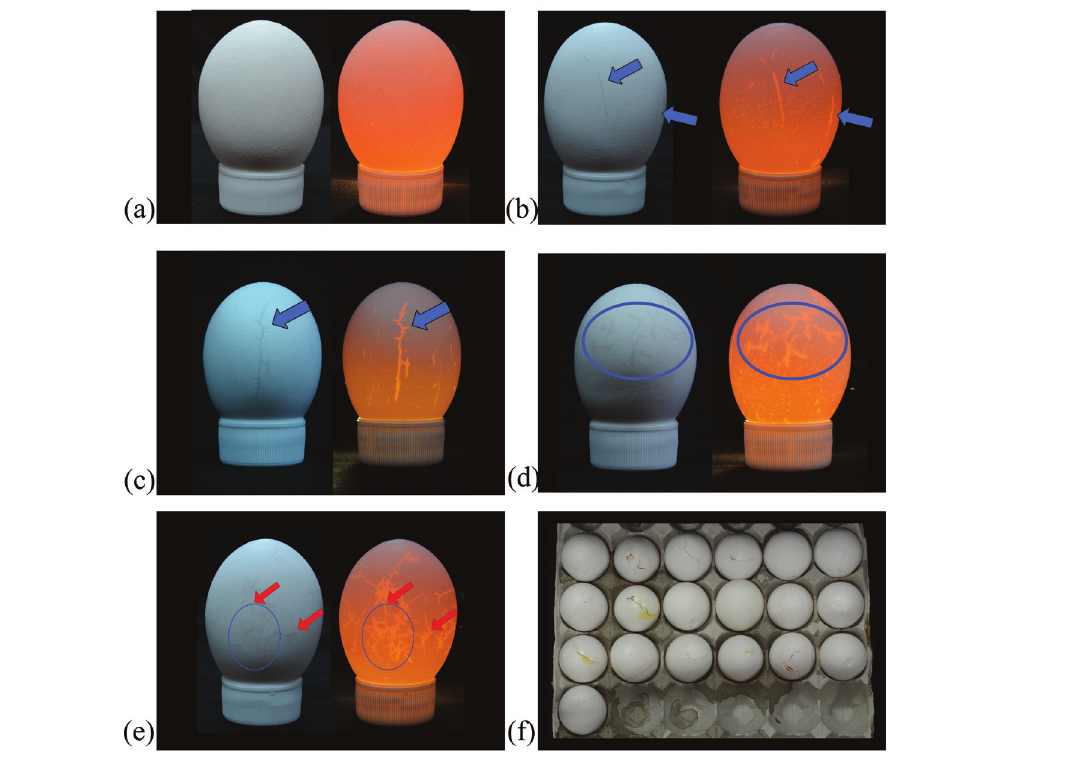
Figure 1. Different categories of eggs based on quality of egg shell; (a) intact eggs (IEs), (b) minor stripe-marked eggs (MEs), (c) severe strip-marked eggs (SEs), (d) severe strip- marked eggs (SEs), (e) cracked eggs (CEs), and (f) broken eggs (BEs). Blue arrows or circles illustrate stripe-marks; red arrows illustrate